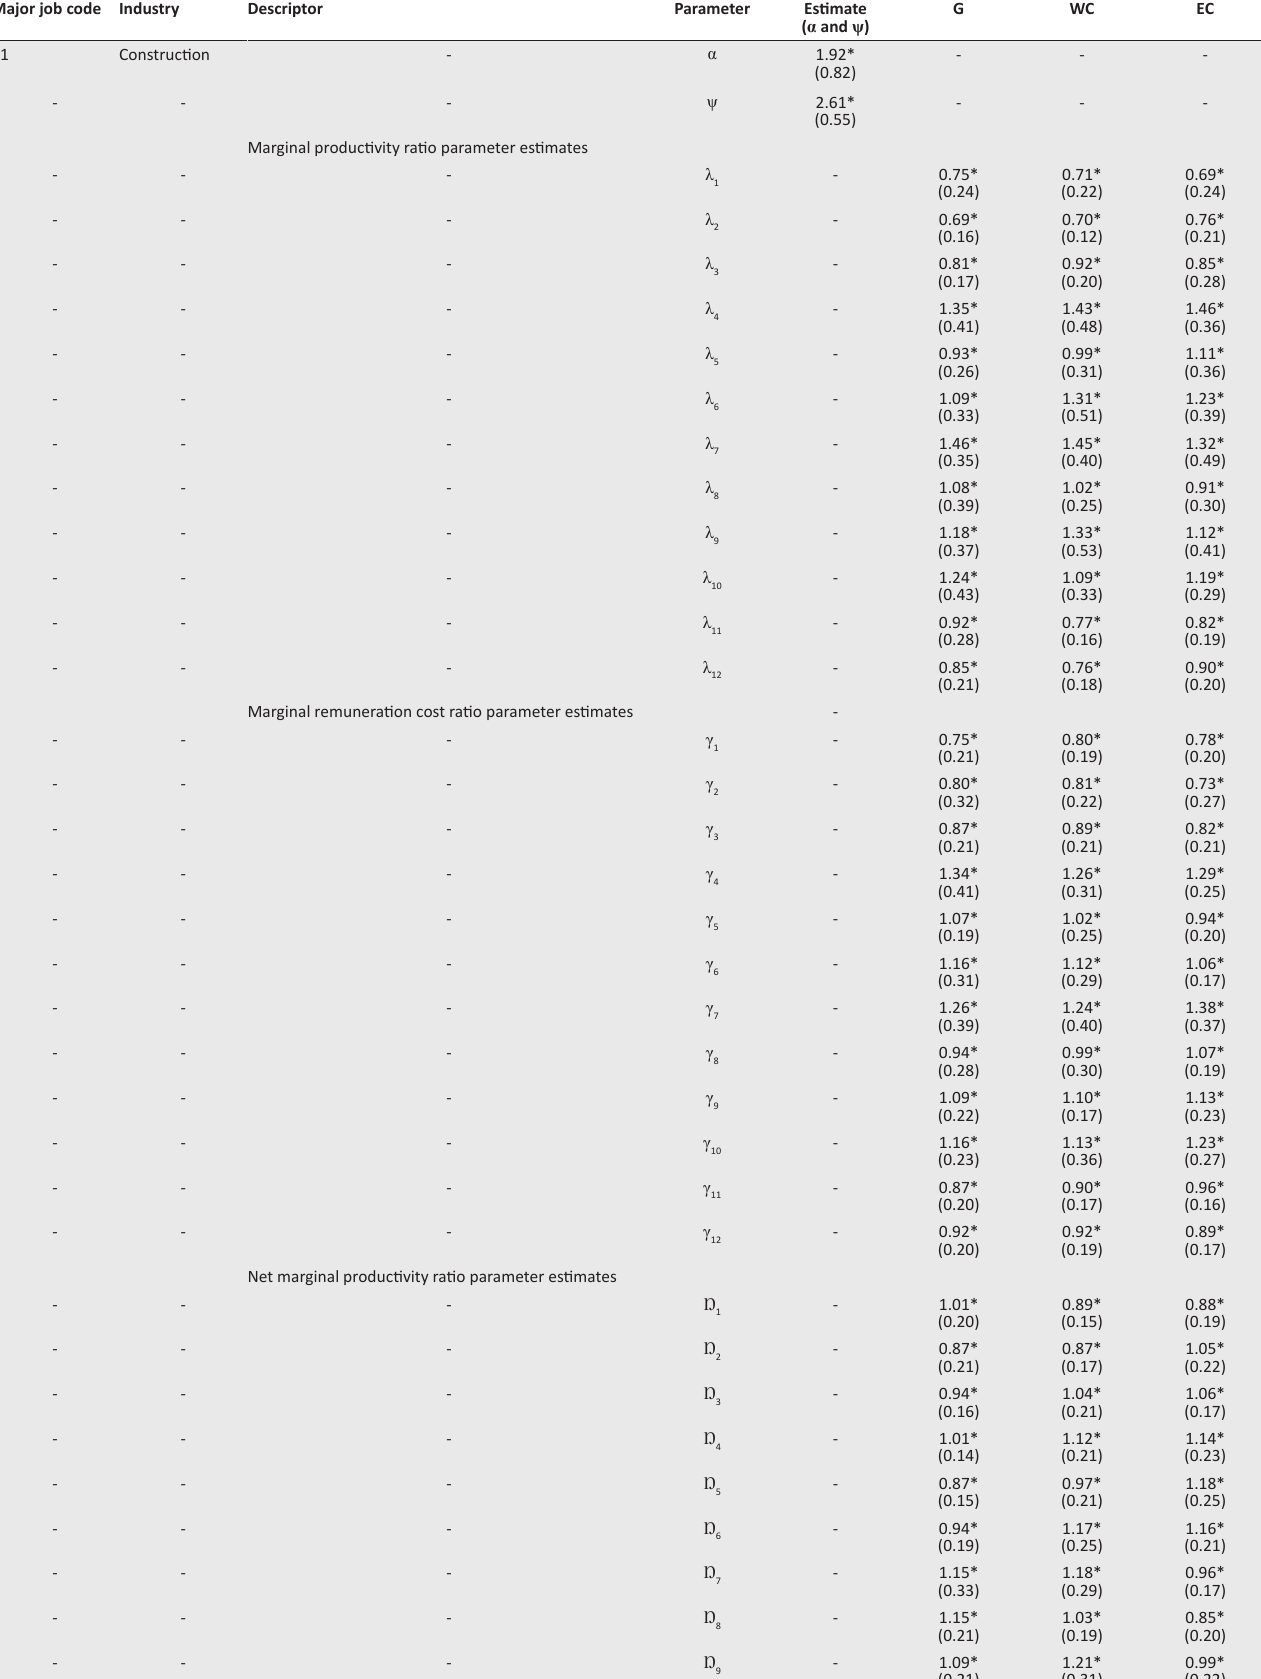
TABLE 3: Capital efficiency, firm-based characteristics and estimates of the marginal productivity model for the construction industries. Major job code